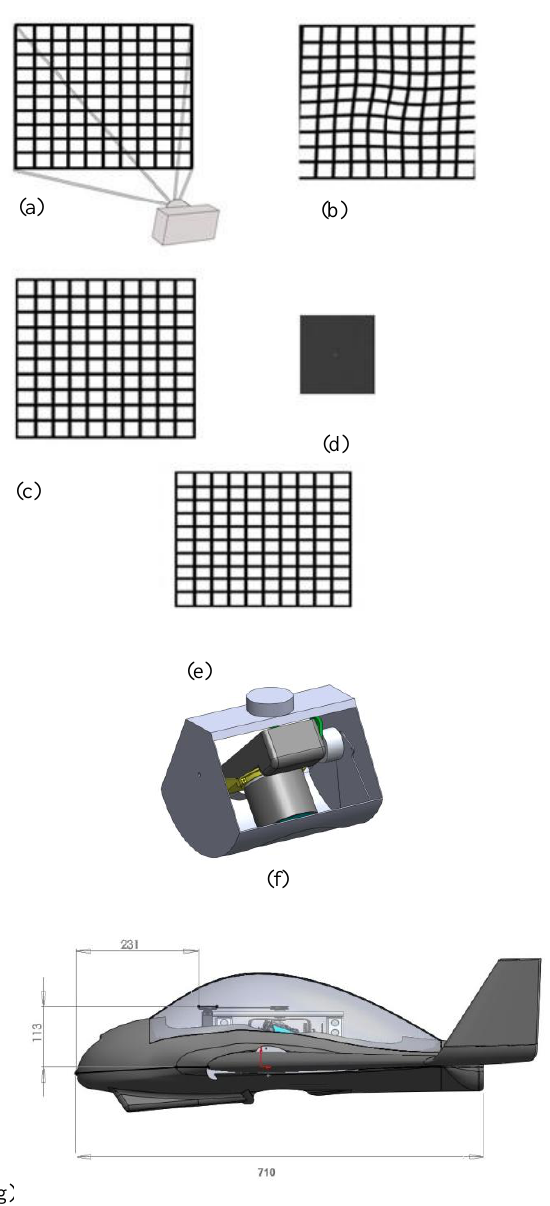
Figure 1: (a) camera sensor exposing the image with rolling shutter, (b) captured photo with side and forward motion of the UAV, image is warped and skewed, (c) captured photo with compensated side and rotational movements of the camera using our proposed method, pixels are stretched only in flight direction, (d) calculated PSF map based on ground and shutter speed, (e) Deconvolved image using generated PSF , image is un-blurred and distortion free, (f) CM with 400 grams net weight including the lens protection door for take-off and landing, (g) CM installed in TopoDrone-100 mapping UAV.